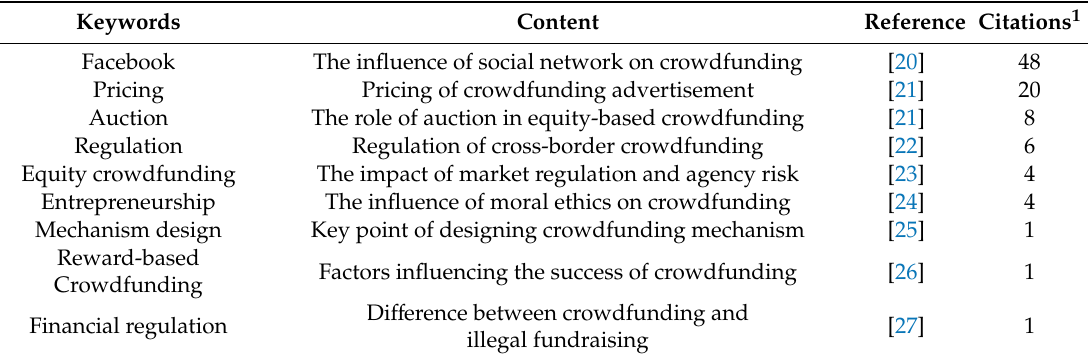
Figure 2. Keywords co-word network of crowdfunding. Table 3. The main information of nodes in network of crowdfunding.